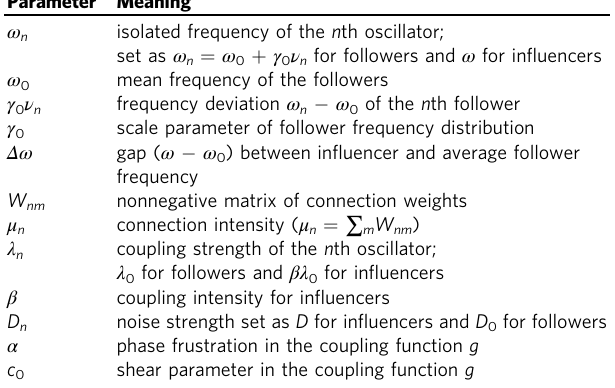
Table 2 Parameters in the model presented in Eq. (1) of the main